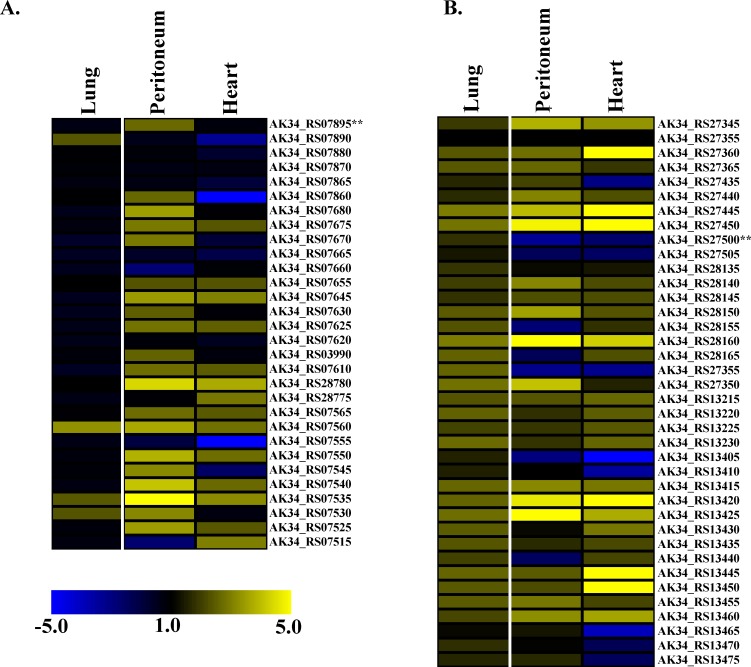
The effect of transposon insertions in the polar and putative lateral flagella genes on lung colonization or septic dissemination of B. dolosa.Insertion site amplification was performed on B. dolosa AU0158 transposon libraries from input or after three selections from two different experiments–mouse lung colonization (“Lung”) or peritoneal injection followed by septic dissemination (site of injection–“Peritoneum”, dissemination–“Heart”). Colors indicated the fold change between input and output samples as indicated in the blue-to-yellow key. Results given for genes suspected to be involved in lateral flagella biosynthesis (panel A) or polar flagellin synthesis (panel B).